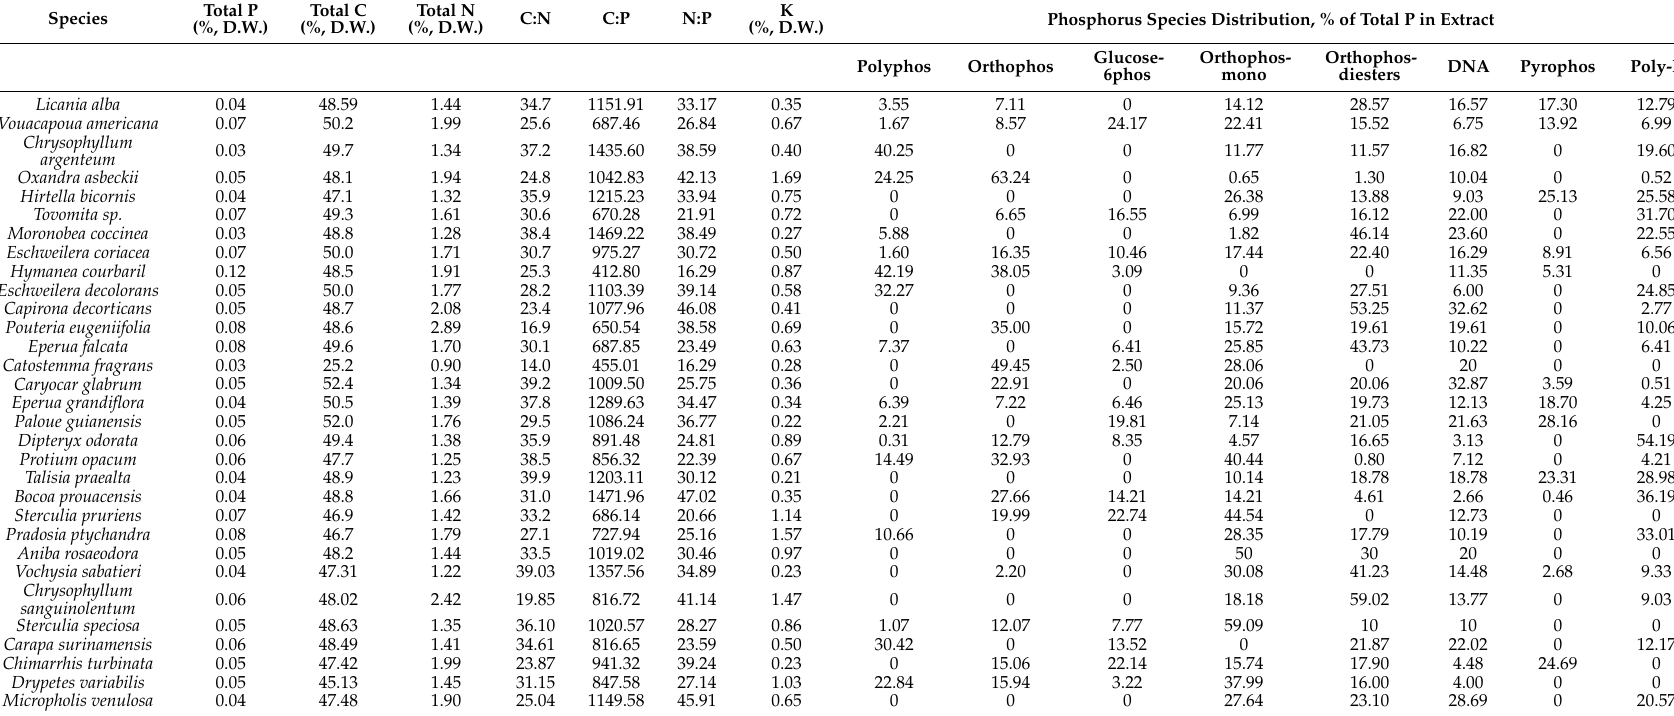
Table 2. Profile of P-compounds in leaf material of tree species. 31 P NMR spectra of NaOH–EDTA extracts (and relative proportions, %) from the leaf samples were